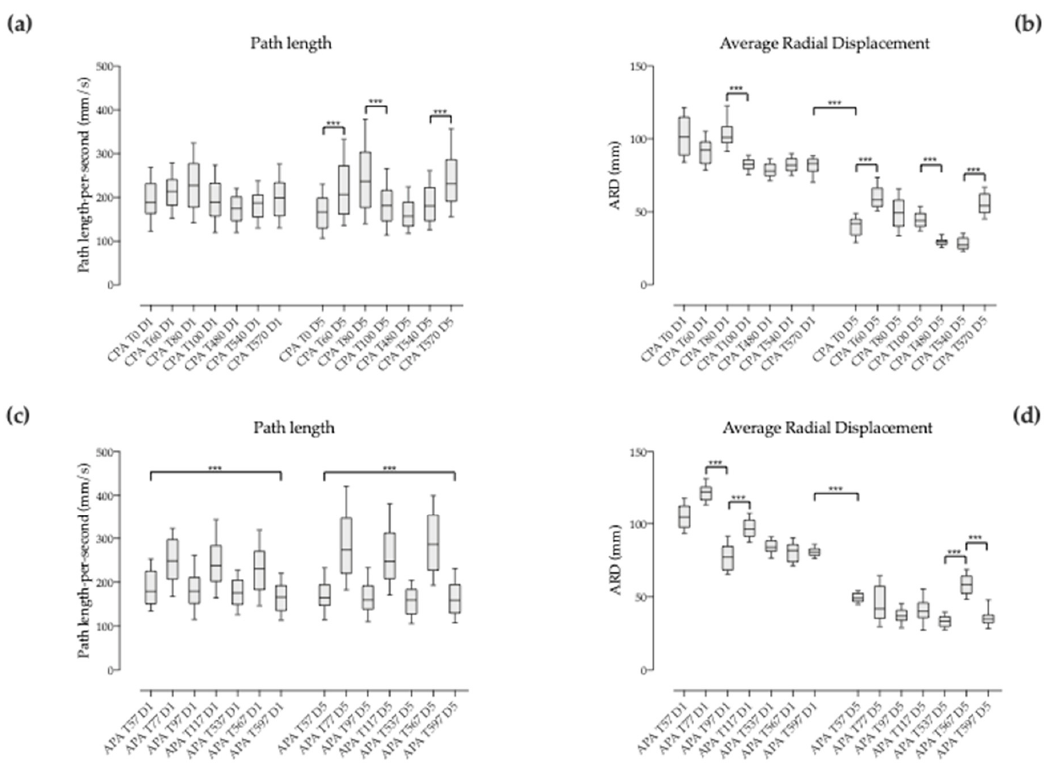
Figure 4. Box and whiskers diagram corresponding to intrasession comparison of: ( a ) COP path length during compensatory postural adjustment (CPA) and ( b ) COP average radial displacement during CPA at di ff erent times within each session during the three seconds that follow each pace change; ( c ) COP path length during anticipatory postural adjustment (APA) and ( d ) COP average radial displacement during APA at di ff erent times within each session during the three seconds before each pace change. D1 corresponds to session 1 and D5 to session 5.